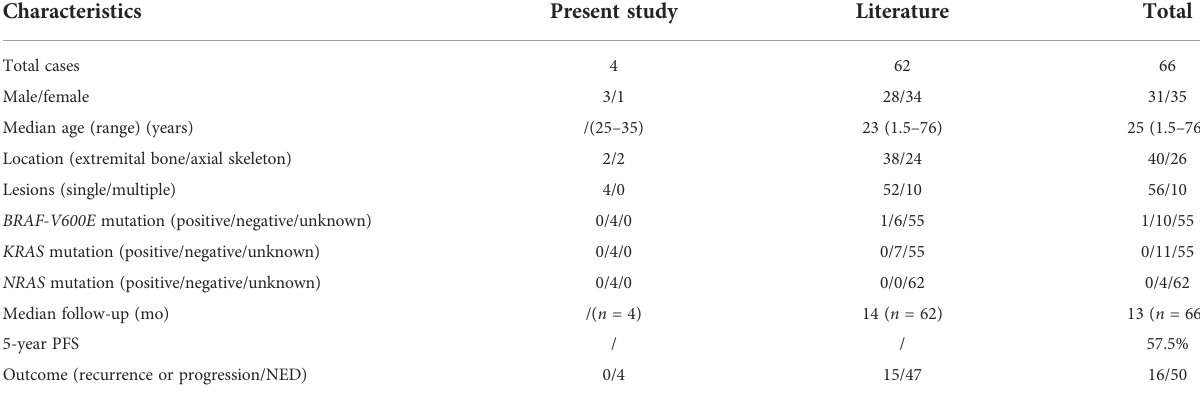
TABLE 2 Summary of the brief clinicopathologic features of primary intraosseous RDD in the present study and the literature.